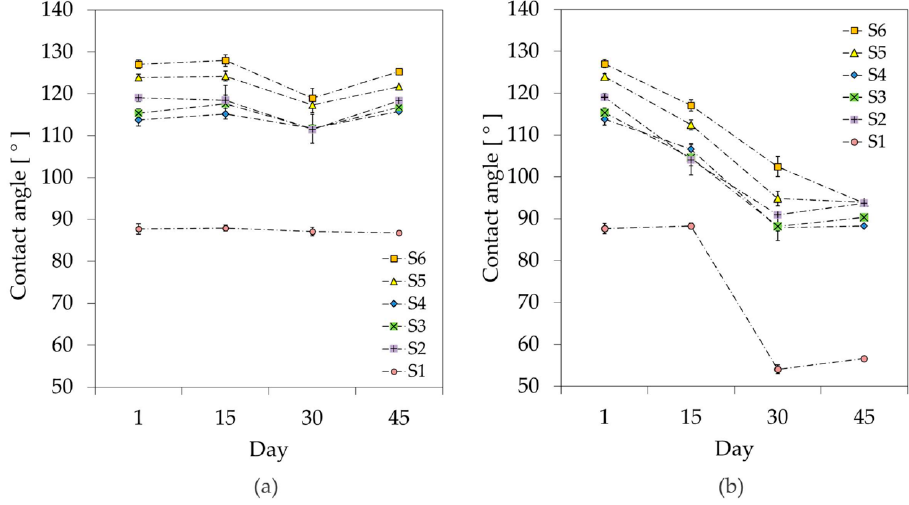
Figure 5. Long term stability study of plasma treated Parylene-C samples: ( a ) stored at room temperature and in dry environment; ( b ) stored in saline solution 0.9%. The error bars represent the standard deviation between three different measurements on three different samples.